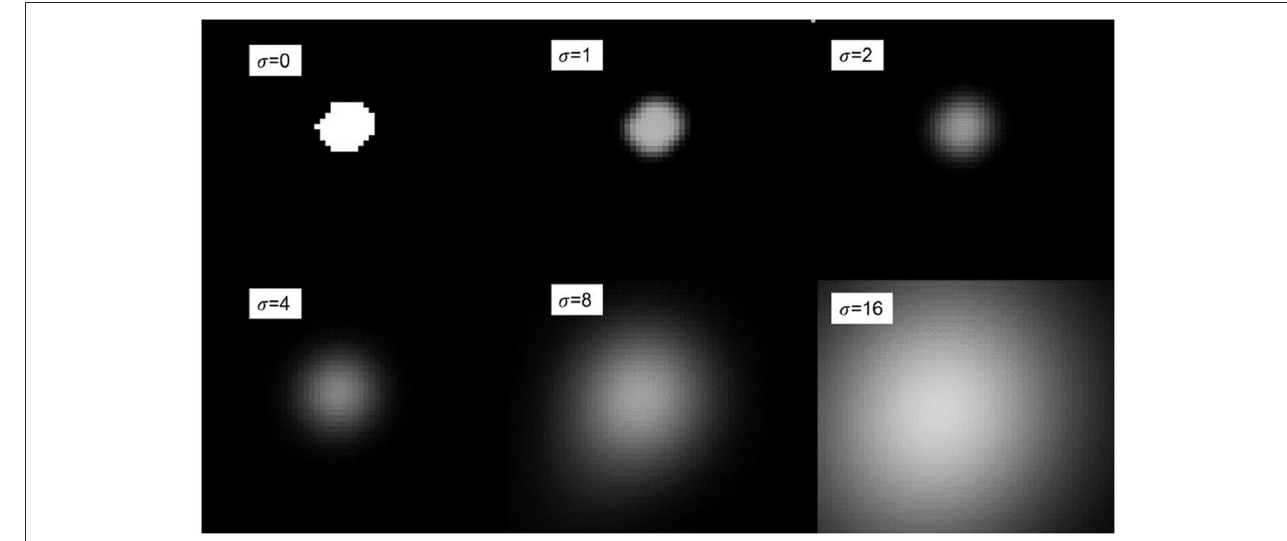
FIGURE 5 | Schematic diagram of Gaussian blur under different variances.